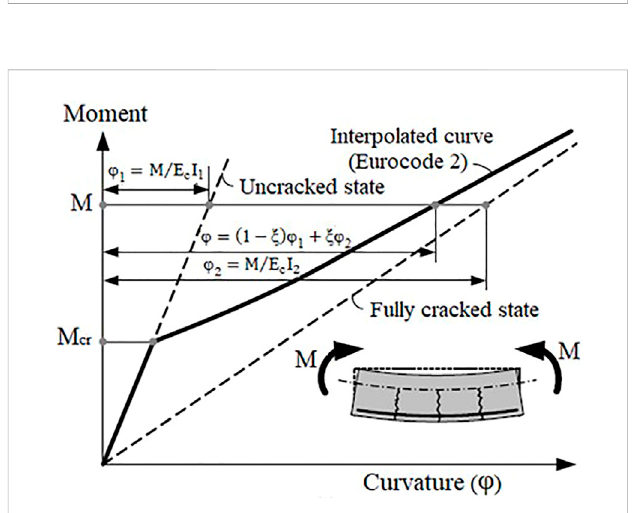
FIGURE 12 Experimentally obtained moment-curvature variation for the slab specimens.